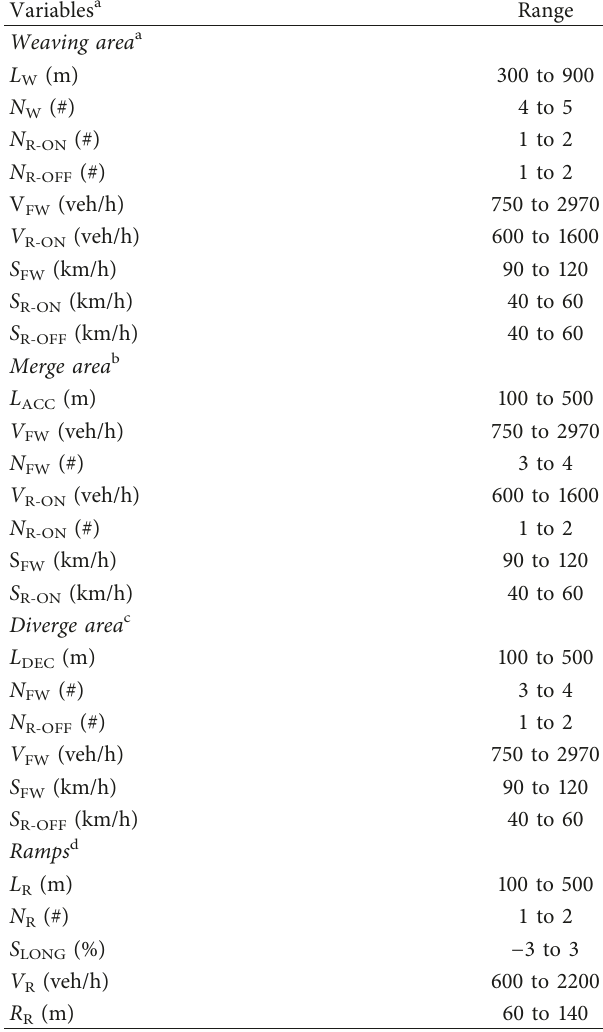
Table 3: Variable description and their range used for simulation.